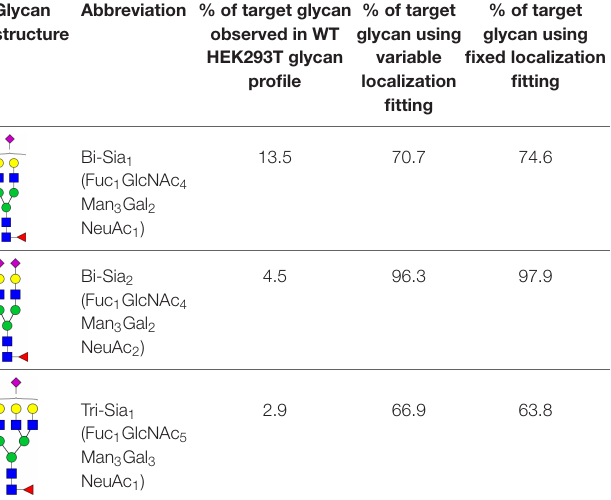
TABLE 1 | Target glycans. Glycan Abbreviation % of target glycan structure observed in